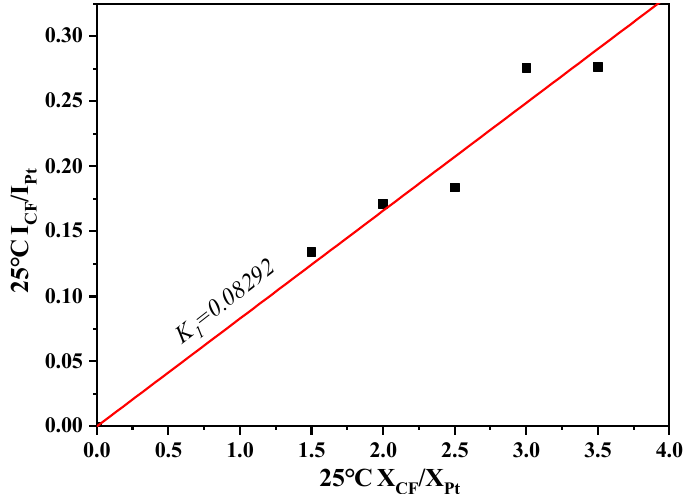
Figure 7. The relationship between the accumulation intensity ratio I CF /I Pt of the diffraction peak and the mass fraction ratio X CF /X Pt at room temperature.